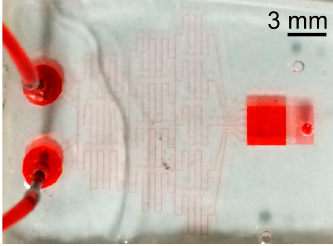
Figure 11. Fabricated microfluidic device to study cell migration inside a tumor.